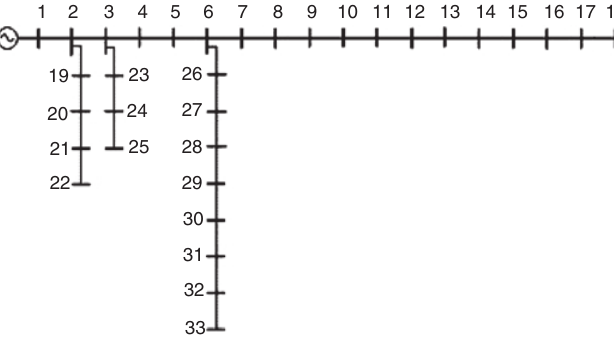
Figure 3: Structure of the IEEE 33 Bus Distribution